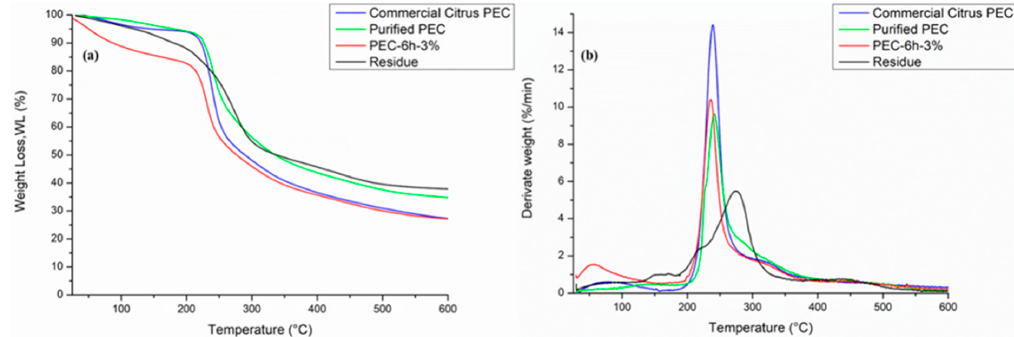
Figure 4. Thermogravimetric analysis (TGA) ( a ) and Derivative Thermogravimetry (DTG) ( b ) thermograms of all pectins and the lignocellulose residue solid. Table 4. Mechanical properties (tensile test) of Purified PEC and PEC films.